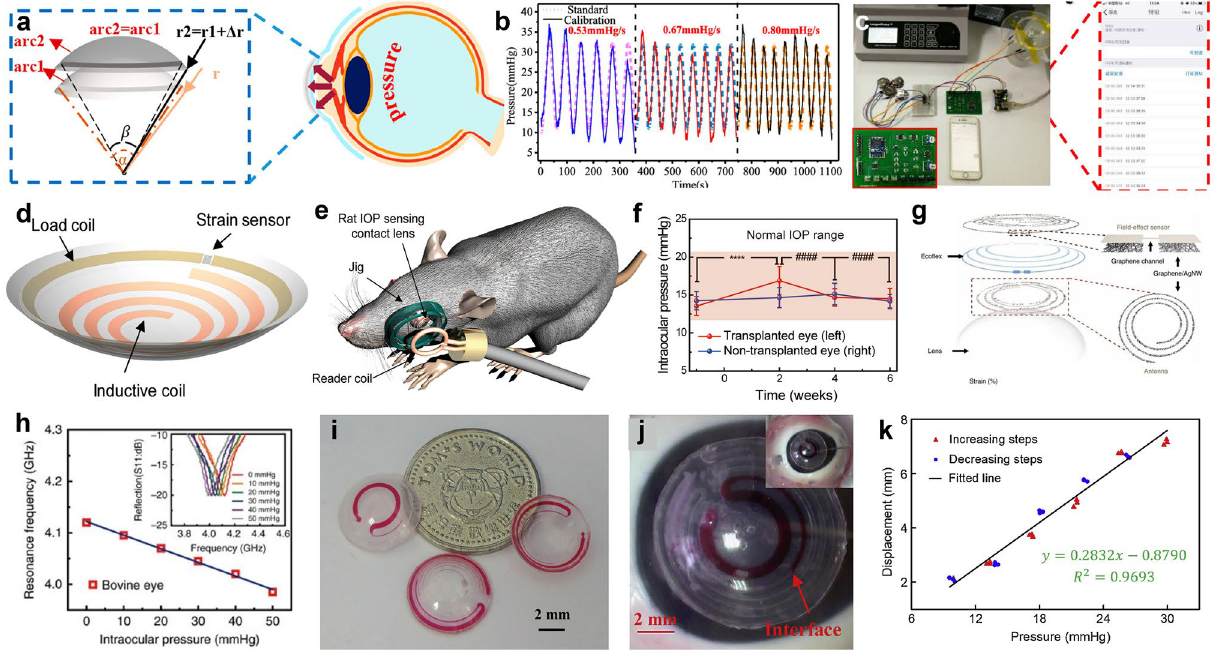
Fig. 10 Soft sensors for IOP. a Schematic diagram of the change of the IOP sensor’s radius of curvature caused by the increase of IOP. b Com- parison of calibrated IOP with the standard values at the speed of 0.53, 0.67, and 0.8 mmHg s −1 , respectively. c Measurements of graphene IOP sensor with portable wireless system. Reproduced with permission [90]. Copyright (2020), American Chemical Society. d Schematic of the strain sensor-based contact lens. e Wireless real-time measurement of IOP in live rat. f Measurements of the IOP of normoglycemic Lewis rats. Reproduced with permission [254]. Copyright (2020), American Chemical Society. g Schematic of the wearable contact lens sensor, integrating the glucose sensor and IOP sensor. h Frequency response of the IOP sensor on the bovine eye from 5 to 50 mmHg. Reproduced with